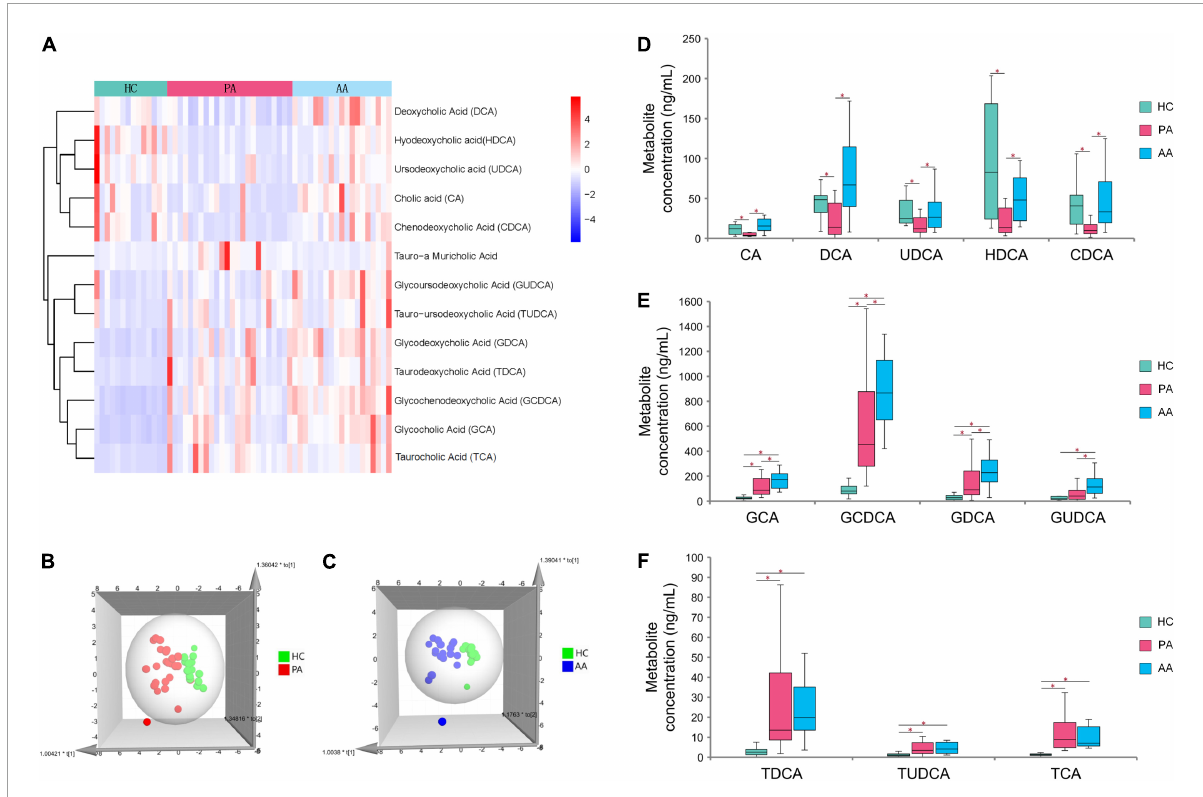
FIGURE3 Analysis of targeted metabolomics between cases and healthy controls. (A) Shows the clustering results of the bile acid P among PA, AA, and HC. (B,C) Show the 3D OPLS-DA scatter plot for PA, AA, and HC, respectively. (D–F) Show the concentrations of thirteen bile acids in PA, AA, and HC. PA: patients in the acute stage. AA, asymptomatic cases at the acute stage; HC, healthy